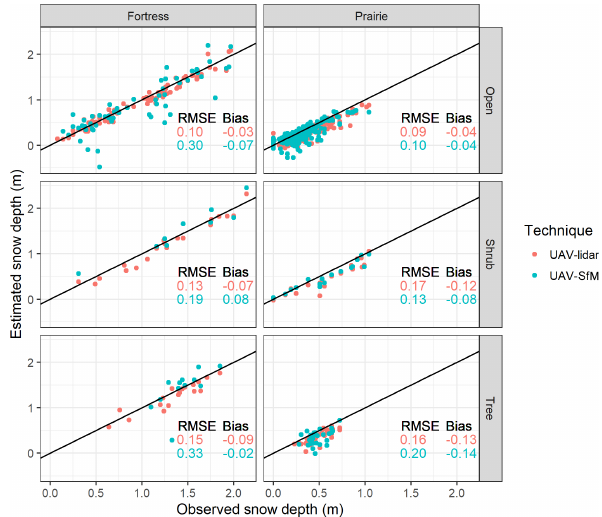
Figure 5. Comparison of snow depth observations from snow probes and snow depth estimates from UAV techniques. Plots are segmented within each vegetation class (rows), site (columns), and observation method